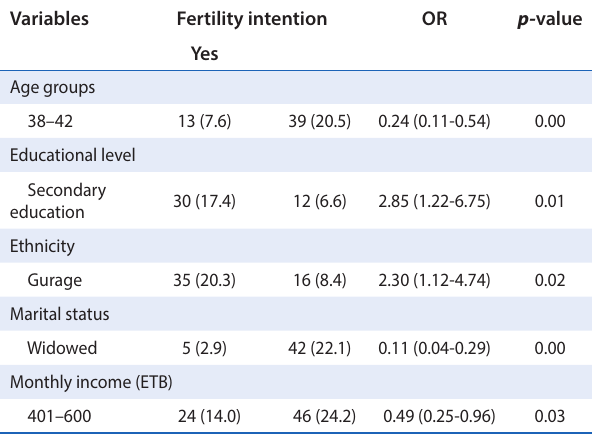
Table 3: Fertility intentions with the socio-demographic